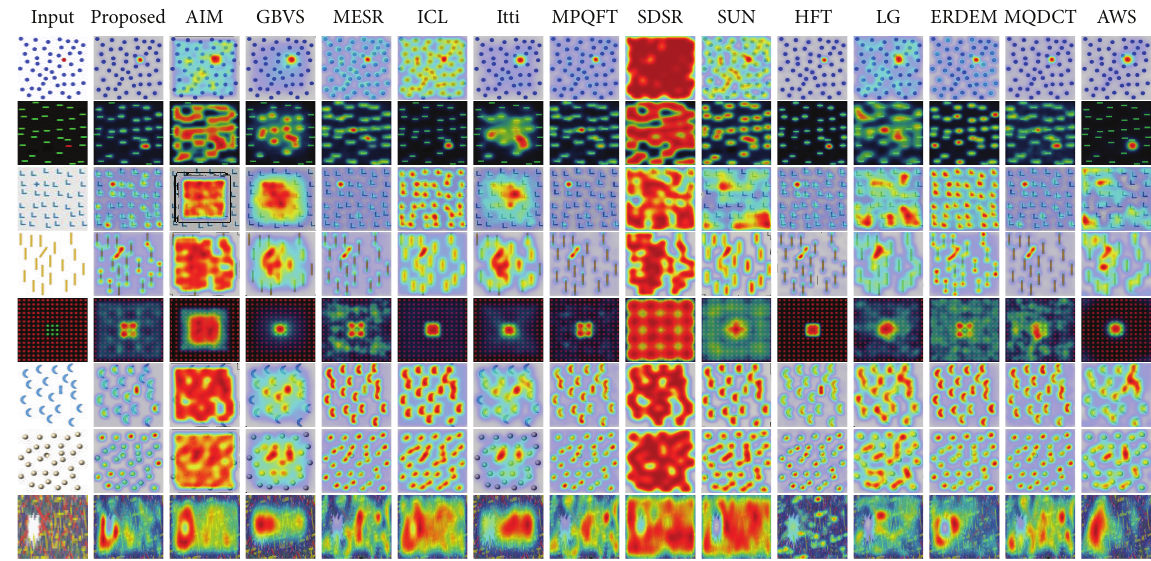
Figure 7: Response of our algorithm and other 13 state-of-the-art algorithms on various psychological patterns